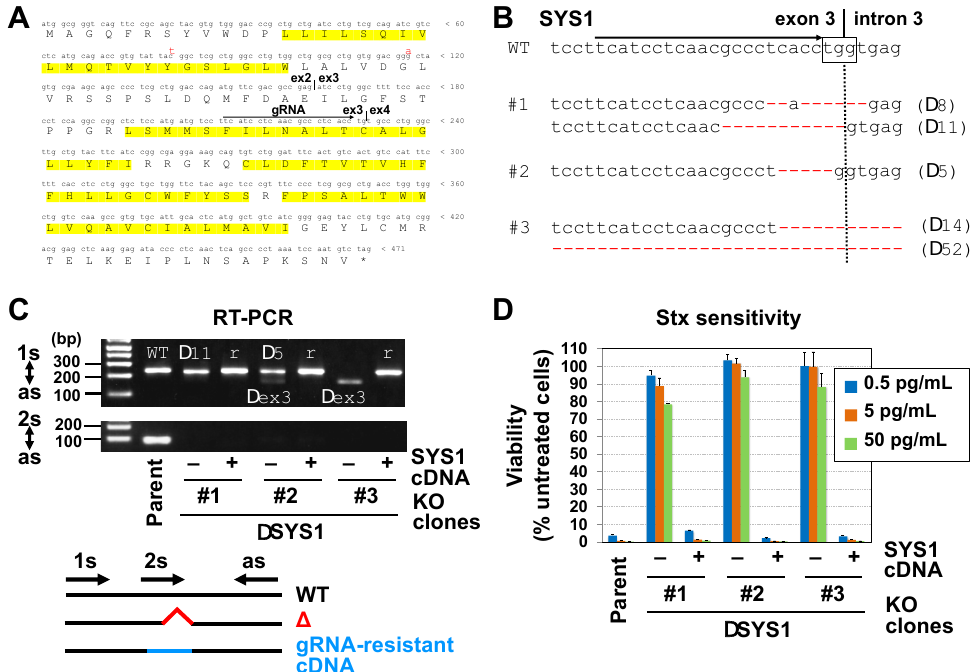
Figure 3. Resistance to STx in Vero C1008 SYS1 -KO cells. ( A ) The open reading frame of human SYS1 cDNA. Red letters indicate AGM SYS1 cDNA sequences. Yellow shadows indicate predicted transmembrane domains. ( B ) Construction of Vero C1008 SYS1 -KO cell clones ( ∆ SYS1#1–3). An arrow indicates the sgRNA-targeted sequence. Red letters in sequences are indicative of deletion mutations, which caused frameshifts shown at the right side of the sequences. Boxes indicate protospacer adjacent motif (PAM) sequences. Further information about the deletion sequences in clone 3 is shown in Figure S1A. ( C ) SYS1 transcript analyses in ∆ SYS1 cells and SYS1 -rescued cells. RT-PCR analyses of SYS1 mRNA in parent cells, ∆ SYS1 cells (“ − ”: cDNA non-introduction), and SYS1 -rescued cells ( ∆ SYS1/SYS1) (“+”: gRNA-resistant SYS1 cDNA introduction) were performed using two pairs of primers. A pair of primers (s1 and as) amplified all SYS1 transcripts, whereas another pair of primers (s2 and as) amplified only non-mutated transcripts but not mutated transcripts and gRNA-resistant cDNA. Sequence results of the PCR fragments that were amplified using the primers “s1” and “as” are shown in Figure S1. ( D ) STx sensitivity in ∆ SYS1 cells and ∆ SYS1/SYS1 cells. Cells were treated with STx1 at the indicated concentrations. Viability was estimated as described in Figure 1B and is expressed as the mean percentage ± SD obtained from three independent